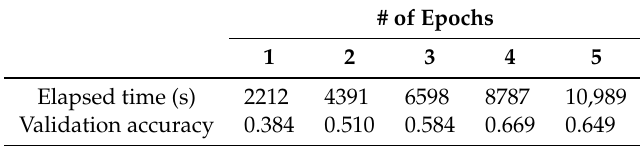
Table 4. Time and accuracy of ResNet 32 × 32 with epoch iteration on ten